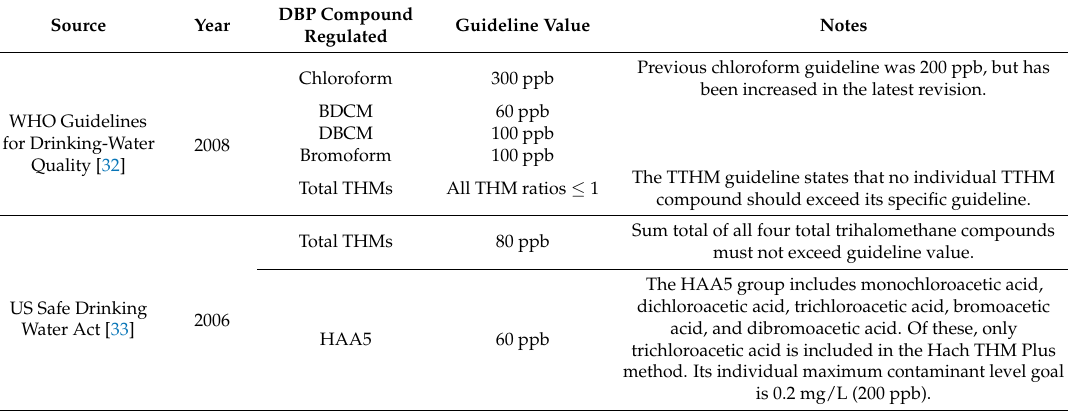
Table 2. Summary of health-related DBP/trihalomethanes (THM) guidelines from WHO and US